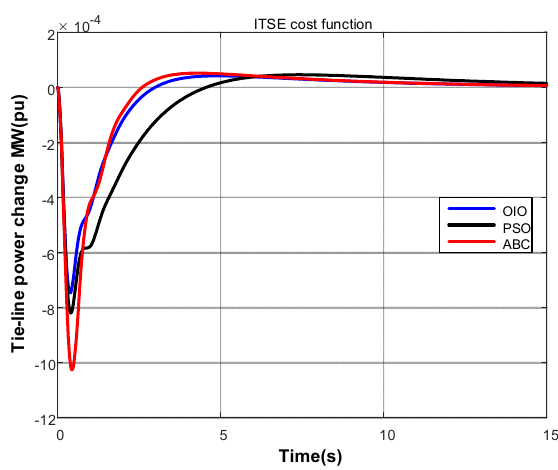
Figure 13. Change in tie ‐ line power for ISE. Energies 2017 , 10 , 2134